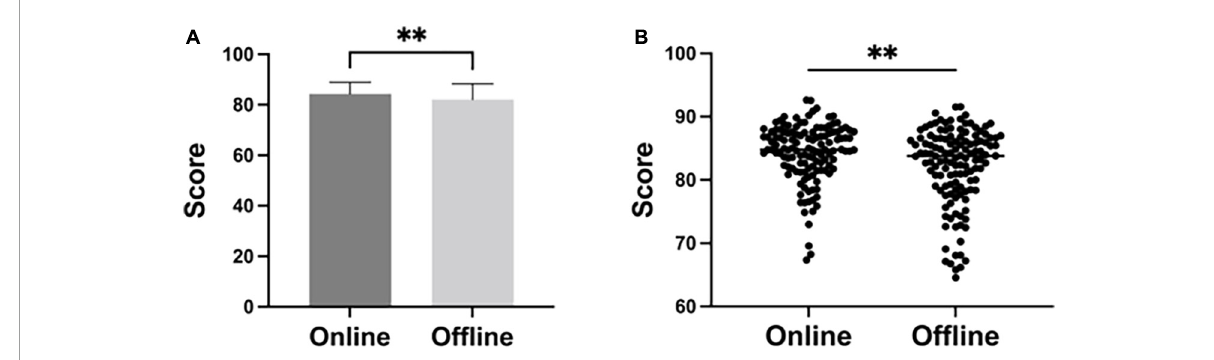
FIGURE3 The average test scores of students taking online classes ( n = 130) and taking offline classes ( n = 130), analyzed by T -test. ∗∗ P < 0.01.